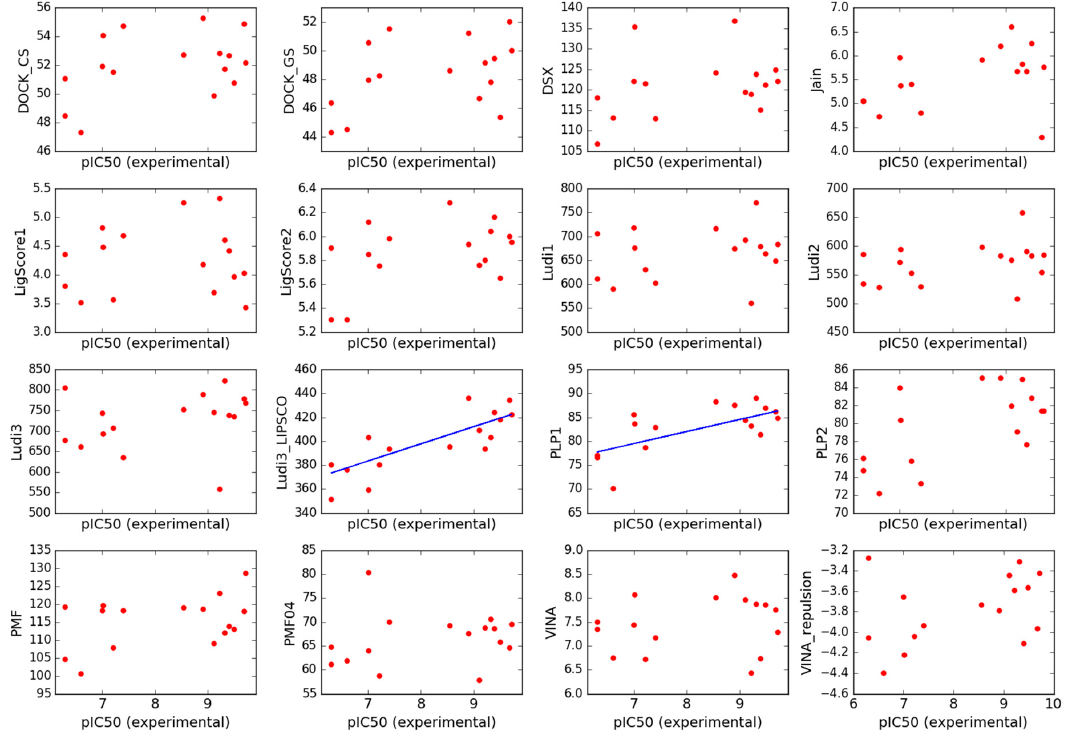
Figure 12. Plots of binding estimation by scoring functions (arbitrary units) against the experimental pIC 50 . The above plots include only the limited subset (without chiral compounds, F07 , F08 and F18 ) See Methods Section for scoring functions labels.